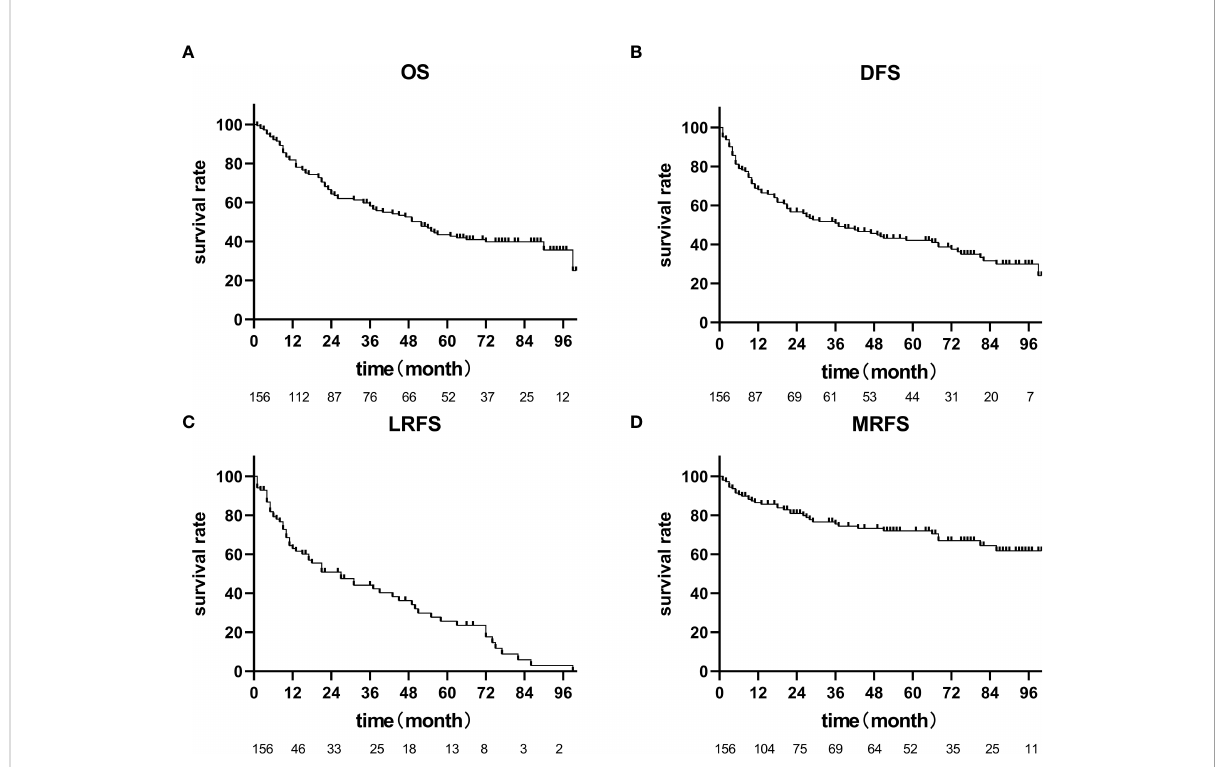
FIGURE 3 OS, PFS, LRFS, MRFS of 156 patients with cervical esophageal cancer treated with radical radiation therapy. (A) The median OS was 49.0 months (35.27-62.73), (B) Median DFS was 31.0 months (14.47-47.53), (C) The median LRFS was 21.0 months (8.22-33.77), (D) Median MFS was not achieved.